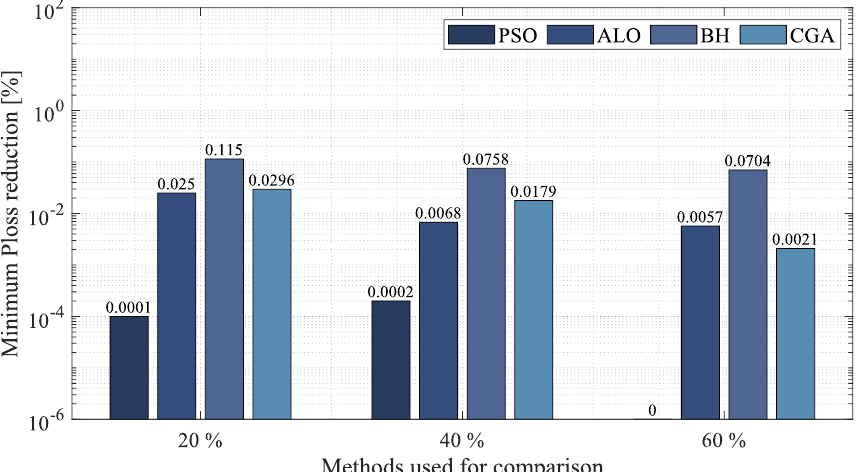
Figure 15. Percentage of reduction of minimum power losses obtained by the MVO in the 10-node mesh test system compared to other